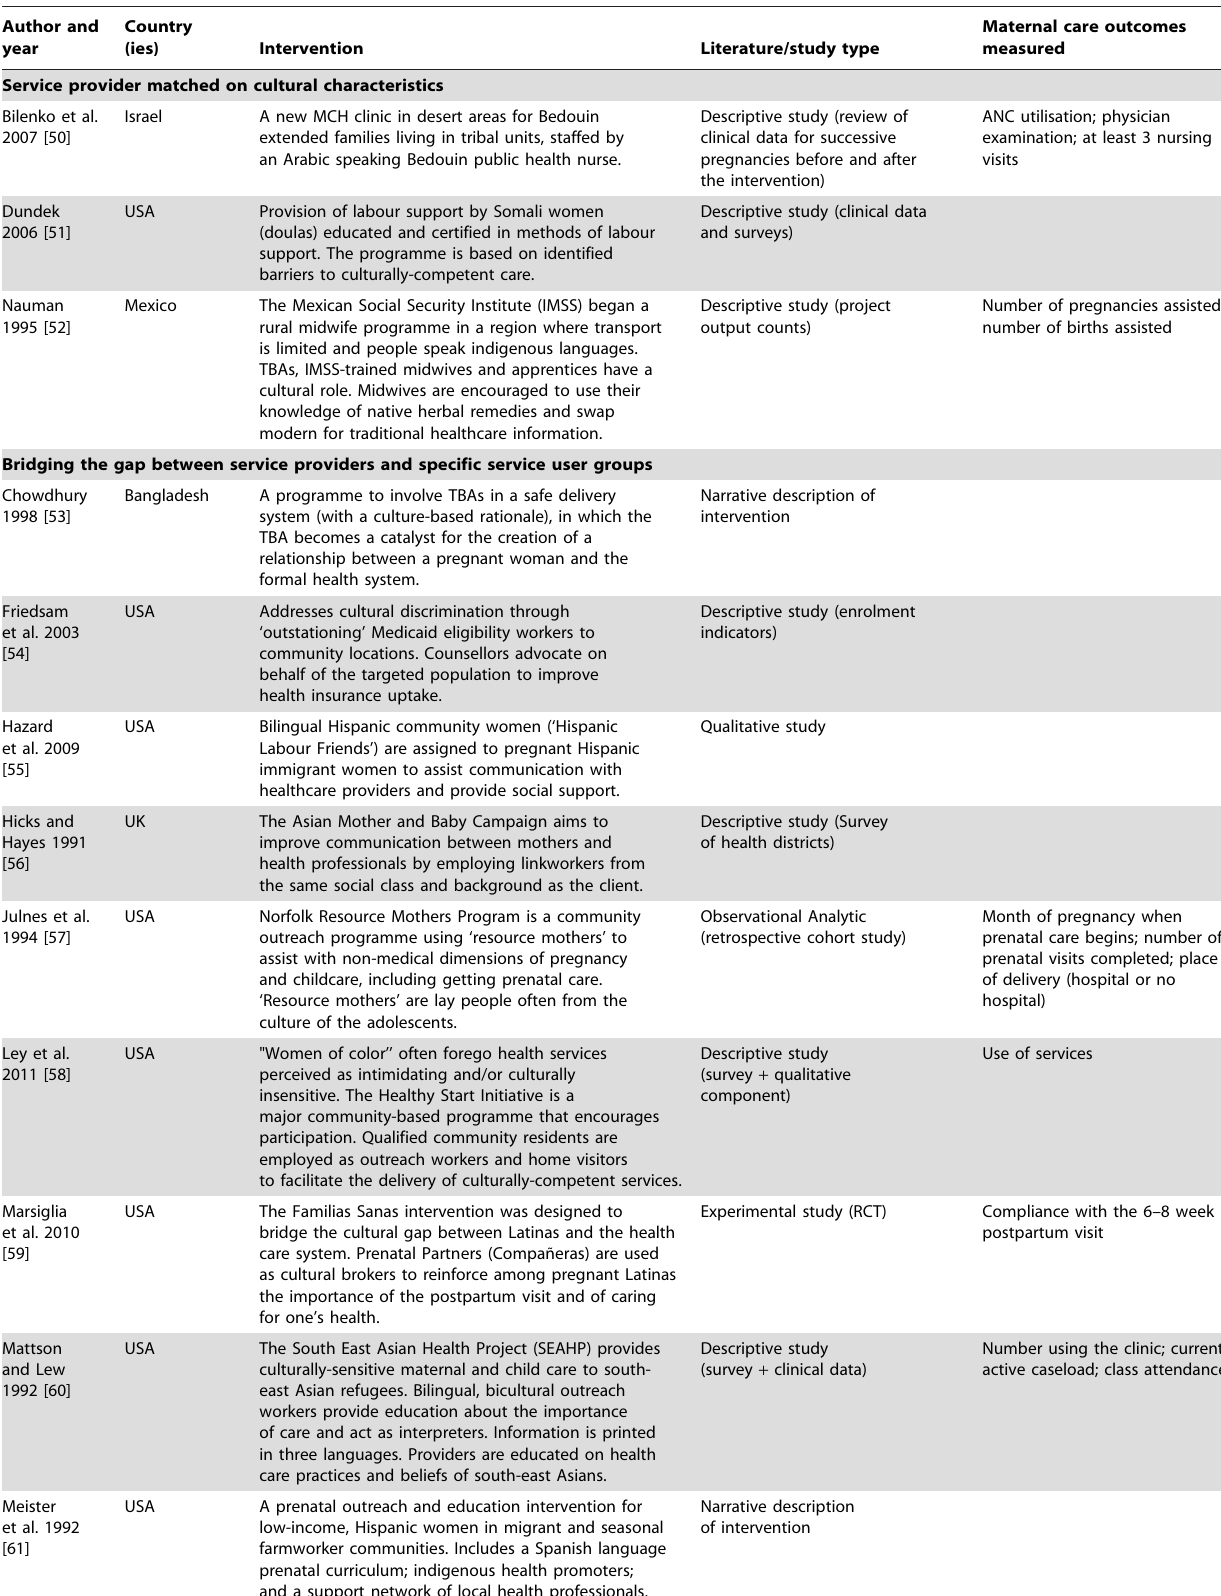
Table 4. Included items: Service provider